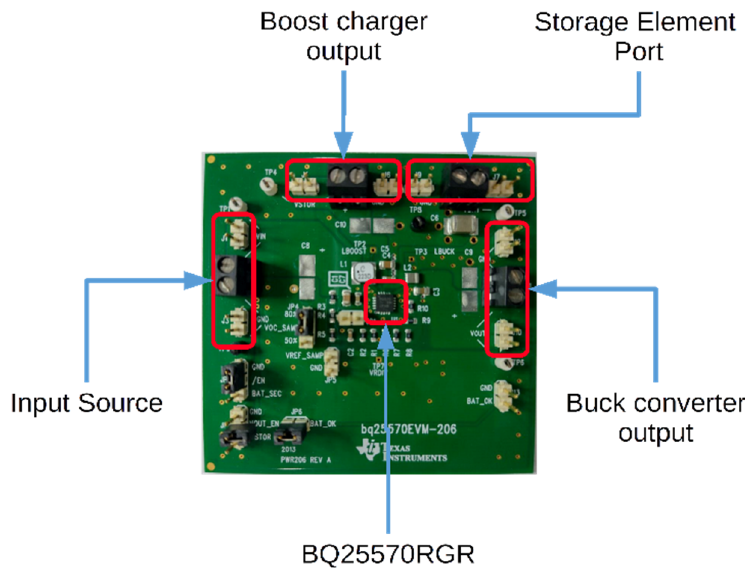
Figure 14. The bq25570 power management module.